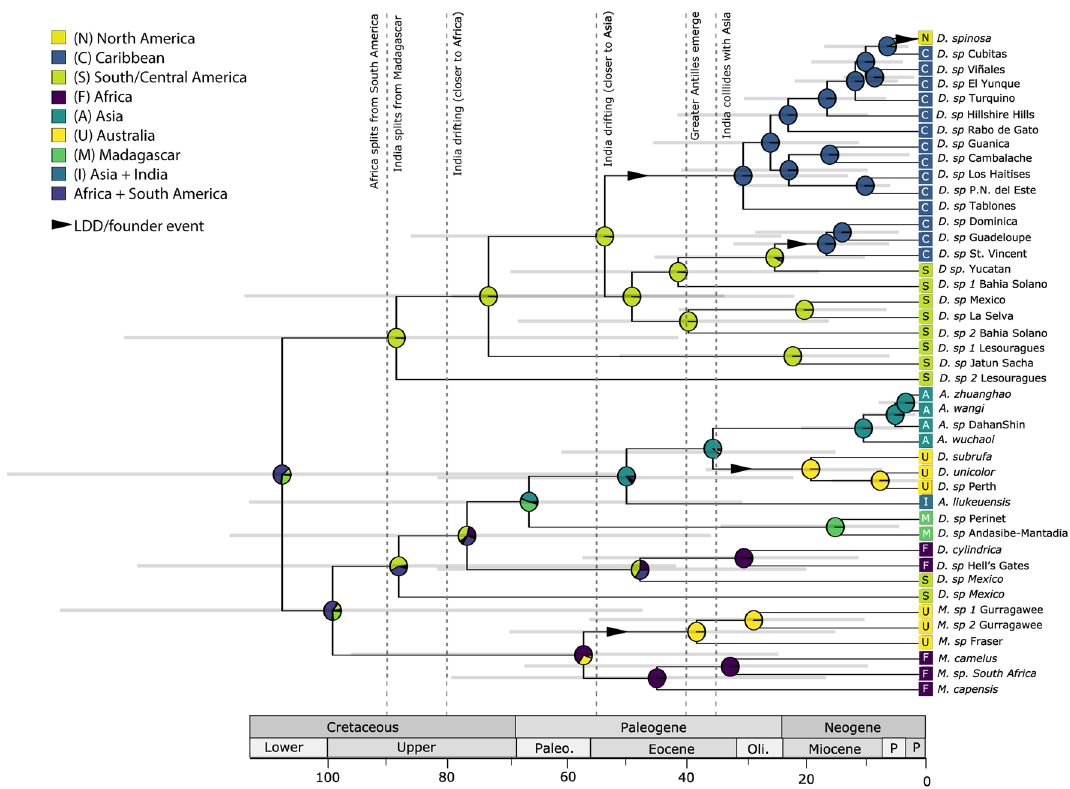
Figure 4. Dated phylogeny inferred using mcmcTREE. Pie charts are colored by geographic range. Major